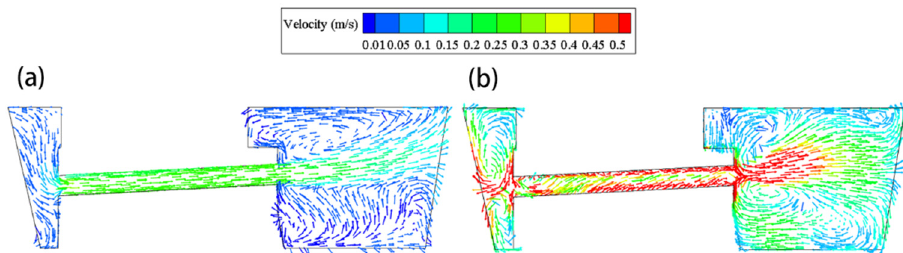
Figure 14. Velocity vector in channel longitudinal section for case S0: ( a ) without induction heating; ( b ) with heating for 200 s at 1000 kW.